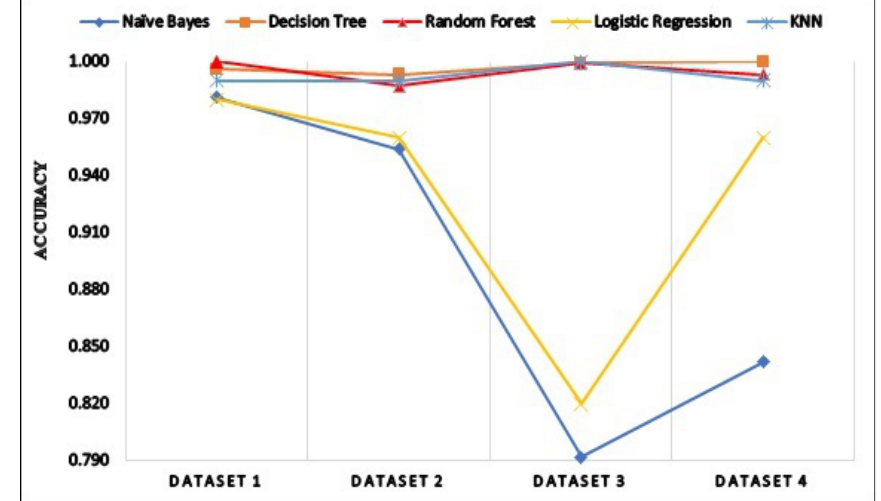
Figure 8. Accuracy of a few well-known supervised ML